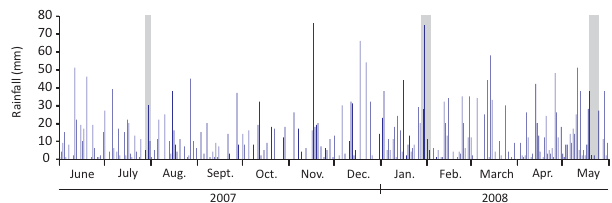
Fig. 4. Daily rainfall in the area. Grey vertical bars indicate the sam- pling